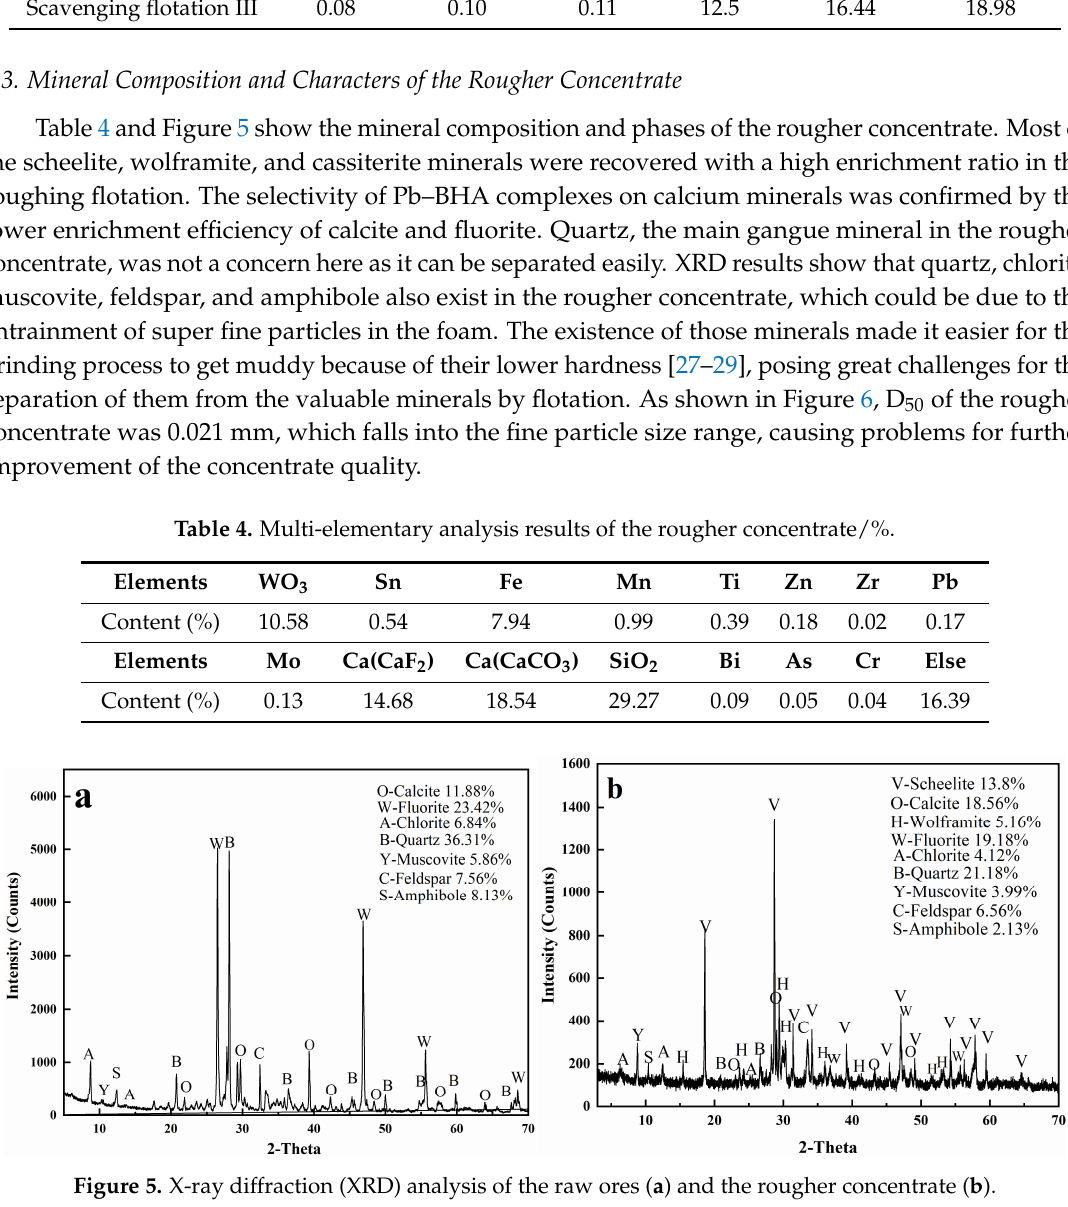
Figure 5. X-ray diffraction (XRD) analysis of the raw ores ( a ) and the rougher concentrate ( b ).